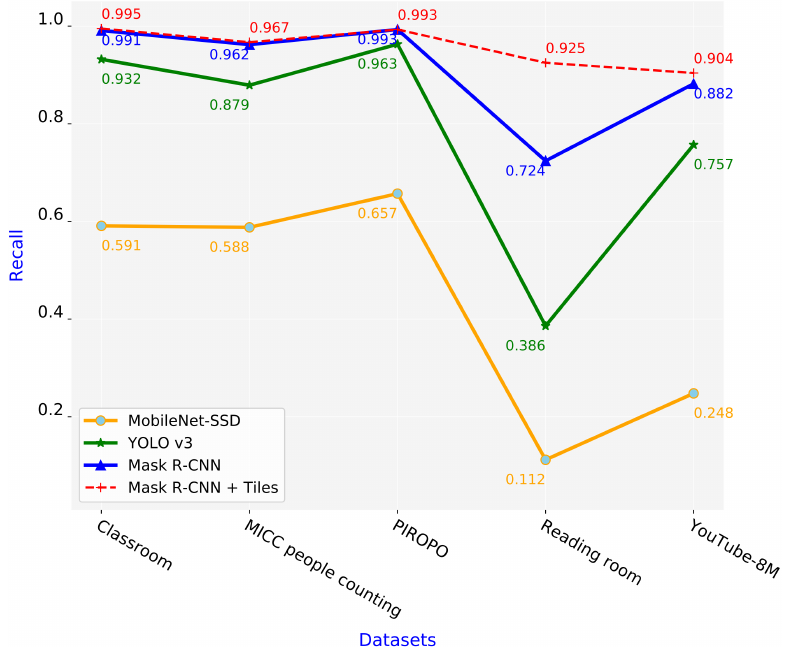
Figure 8. Recall values of four